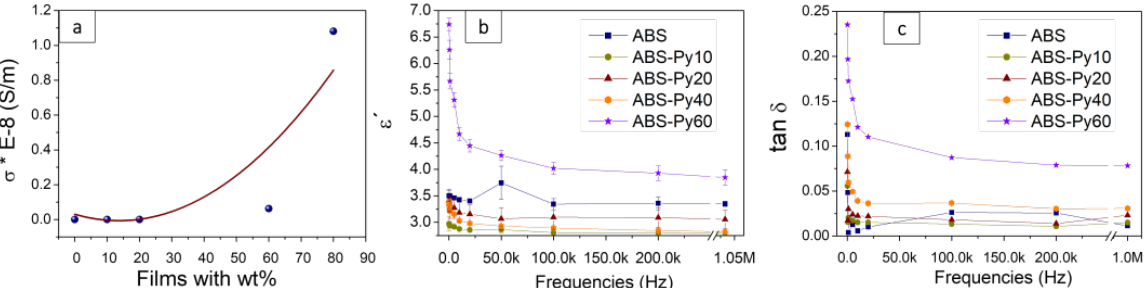
Figure 6. ( a ) Electrical conductivity of pristine ABS and the respective composite for ABS–Py with different wt% (the curve, to guide the eyes, represents a second order polynomial fitting). ( b ) Dielectric constant ( ε ’) of pristine ABS and the respective composite. ( c ) Dielectric losses (tan δ ) of pristine ABS and the composites.